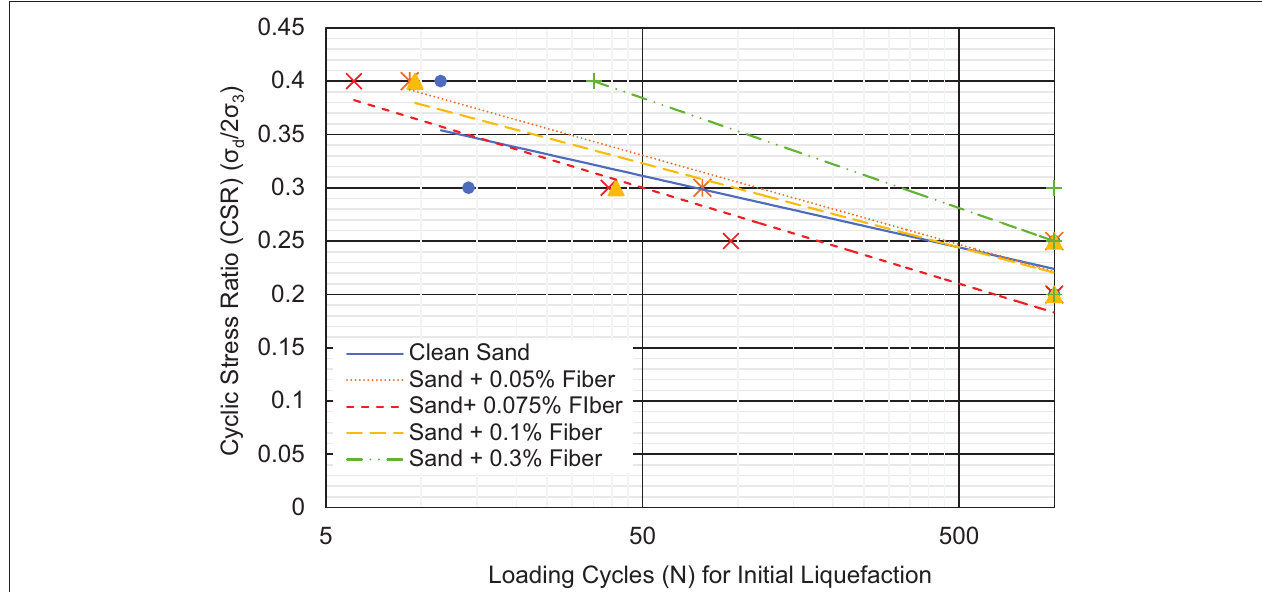
FIGURE 1 | Initial liquefaction resistance of sand containing various percentages of fiber at 34.48 kPa effective confining pressure.